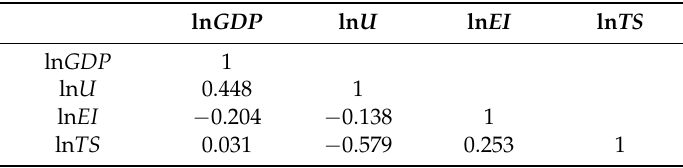
Table A1. Correlation among the explanatory variables.